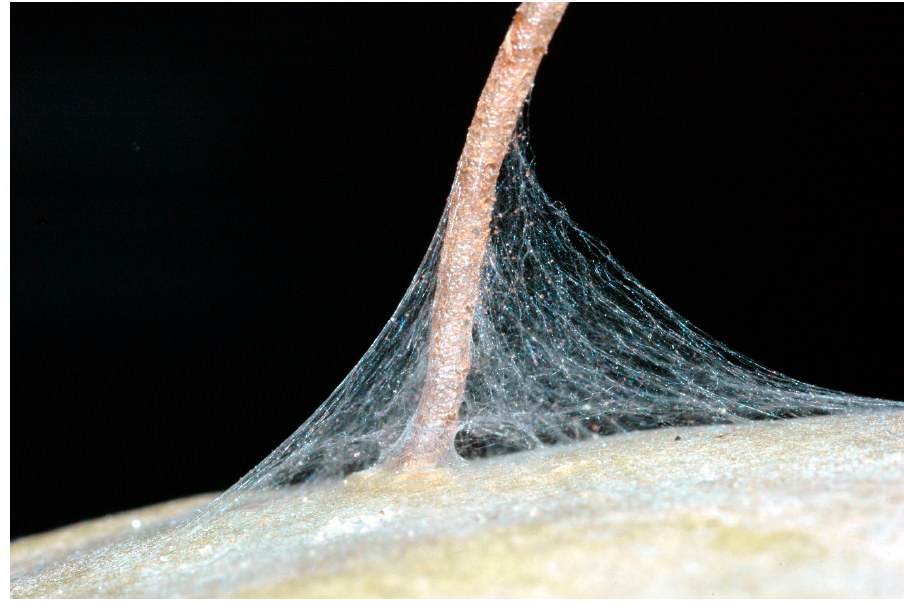
Figure 1. Silk covered arena formed by neonate Cactoblastis cactorum caterpillars at the base of the egg stick.